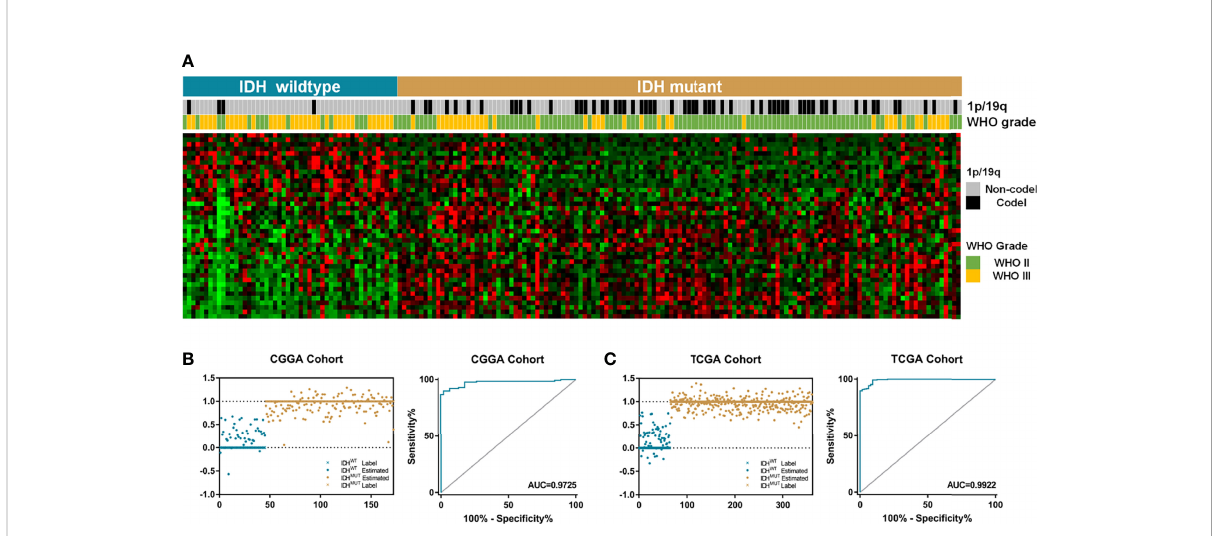
FIGURE 1 The IDH-associated a -KG-dependent gene signature. (A) The LGG patients were classi fi ed into two groups based on relevant IDH status. A total of 41 genes were differentially expressed between IDH WT and IDH MUT groups. (B) The signature comprising 41 genes could be used to distinguish IDH phenotypes with an AUC of 0.973 in CGGA dataset. (C) In TCGA cohort, the enzyme-based signature could divide LGG samples into two groups with an AUC of 0.992. a -KG, alpha-ketoglutarate; LGG, lower-grade glioma; AUC, area under the curve; CGGA, Chinese Glioma Genome Atlas; TCGA, The Cancer Genome